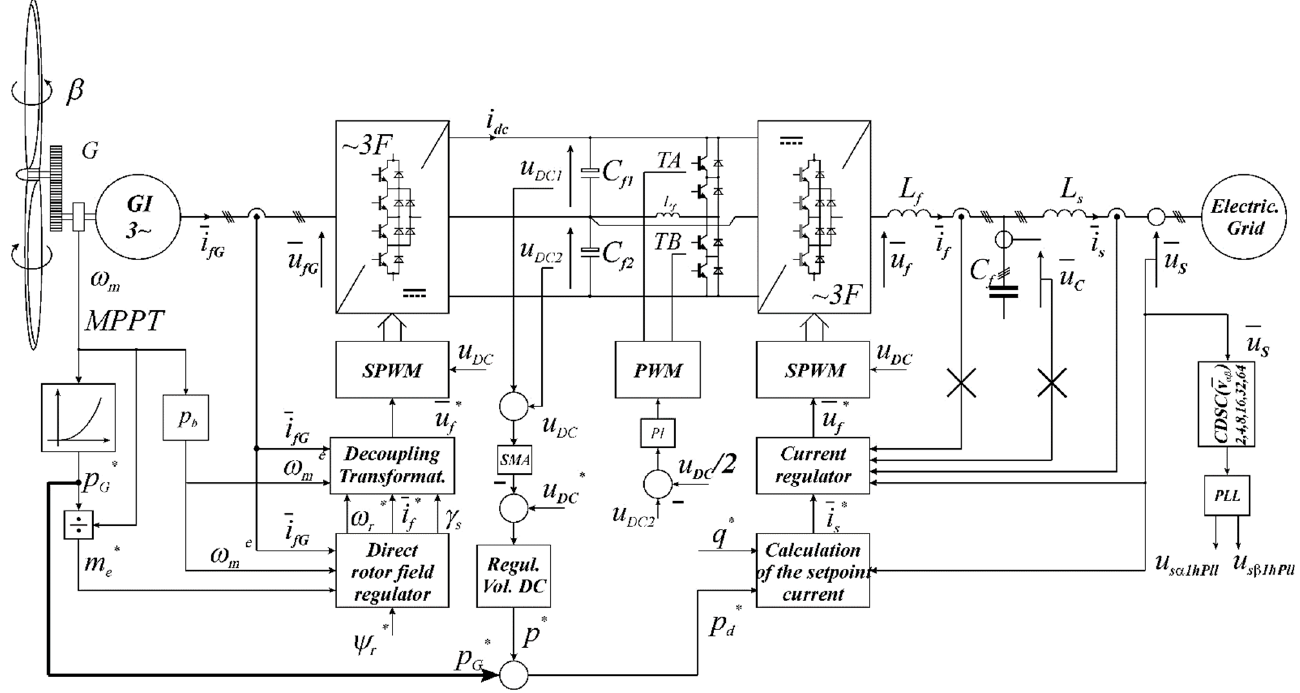
Figure 9. Wind power plant with an induction generator and AC/DC/AC converter based on three-level inverters.